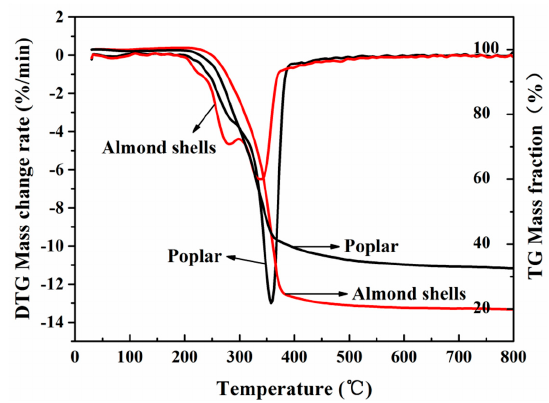
Figure 6. Thermal gravity and derivative thermogravimetric.